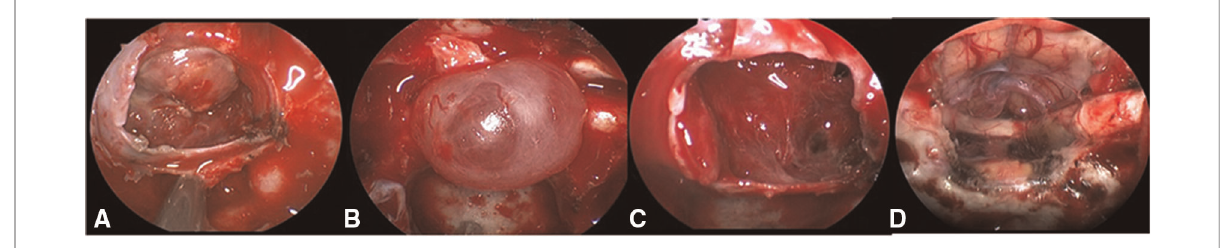
FIGURE 1 Grading of CSF leakage during operation. ( A ) Grade 0: the sellar diaphragm was intact and no CSF leakage after tumor resection. Postoperative pathology showed that one case had no functional pituitary adenoma. ( B ) Grade 1: the sellar diaphragm was intact and a small vesicle with CSF accumulation was formed around it after tumor resection. Postoperative pathology showed one case of nonfunctional pituitary adenoma. ( C ) Grade 2: the sellar diaphragm defect and moderate CSF leakage can be observed after tumor resection. Pathology showed one case of nonfunctional pituitary adenoma. ( D ) Grade 3; postoperative pathology showed one case craniopharyngioma of with extensive suprasellar arachnoid cistern opening during operation. CSF, cerebrospinal fl